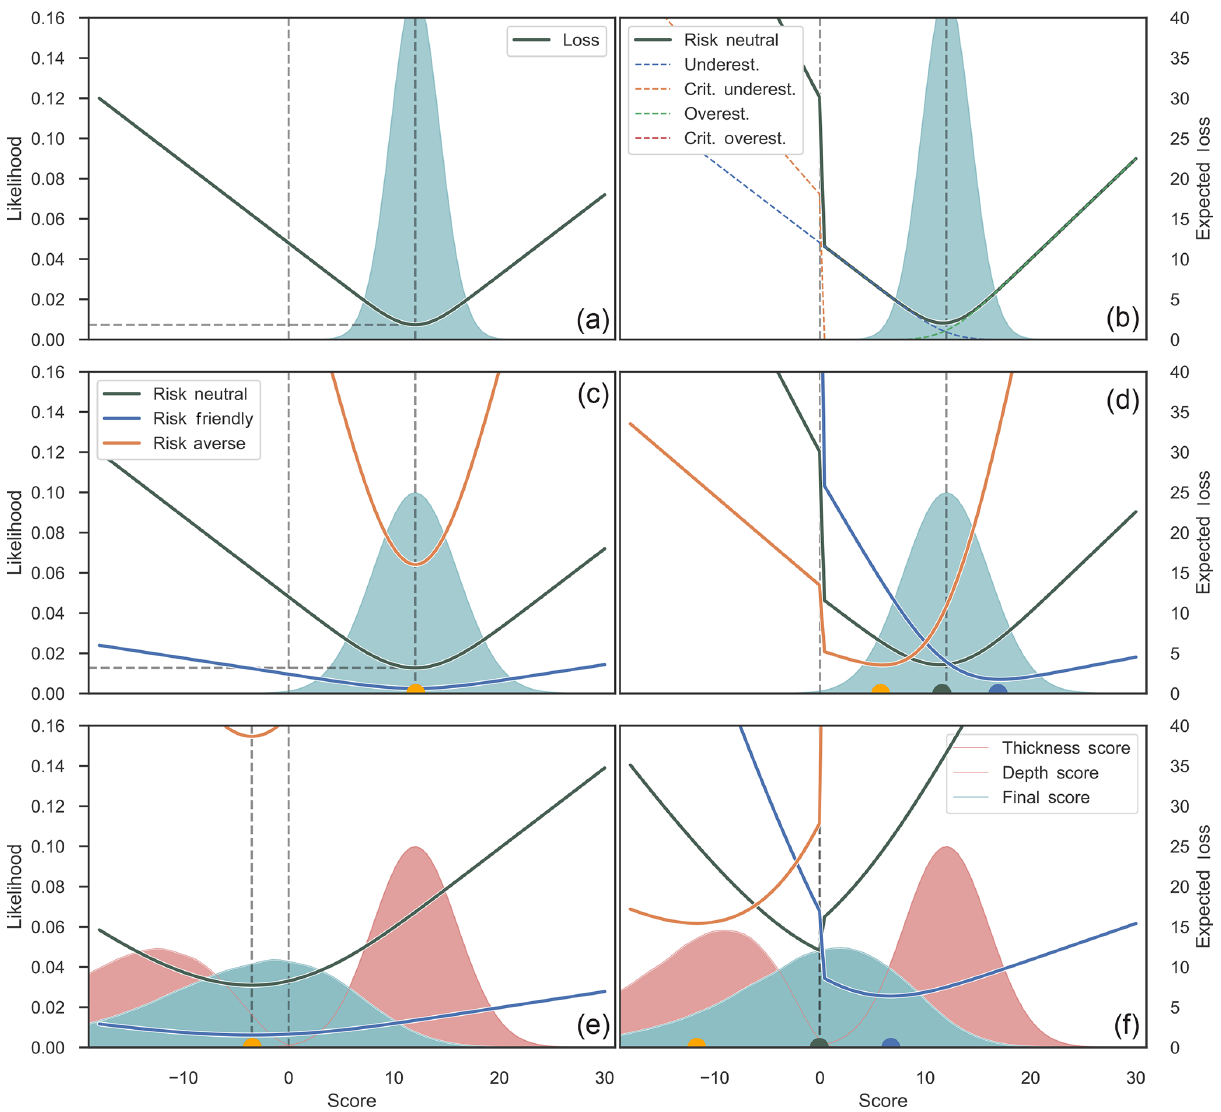
Figure 1. Illustration of different steps and aspects of our loss function customization. Functions are applied to an abstract score as the parameter of